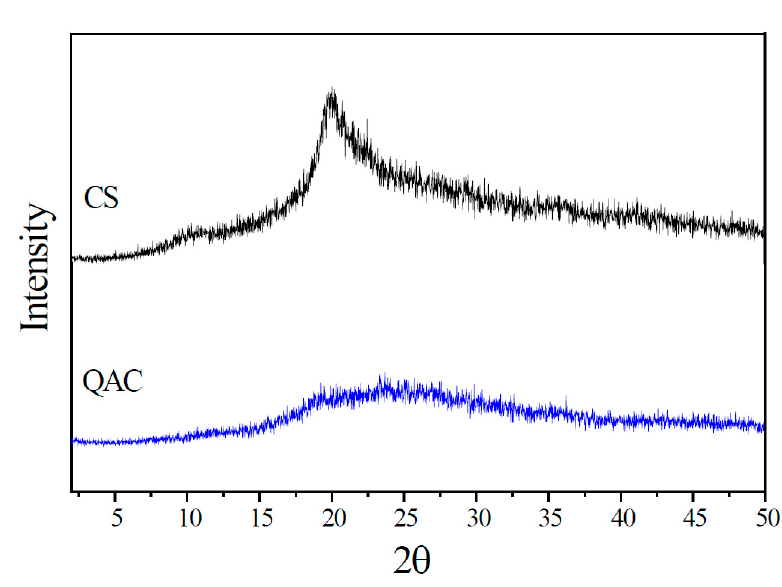
Figure 3. FTIR spectra of CS and QAC.